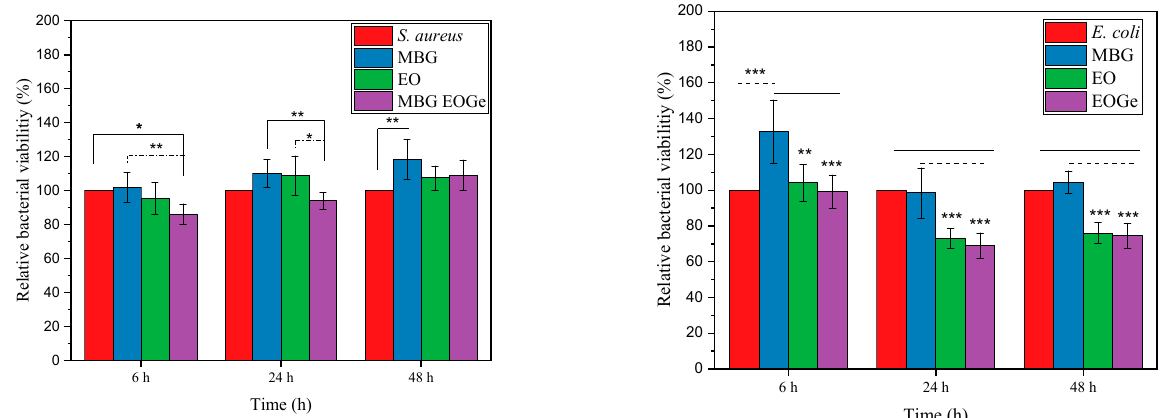
Figure 9. Relative bacterial viability for the MBG, MBG EO and MBG EOGe particles after 6, 24 and 48 h incubation with with S. aureus (Gram-positive) and E. coli (Gram-negative) bacteria. The asterisks indicate significant differences. * p < 0.05, ** p < 0.01 and *** p < 0.001.